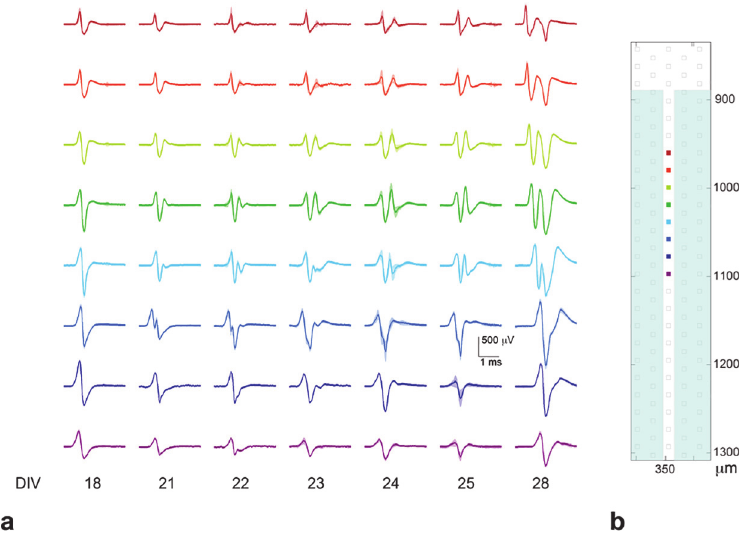
Fig 6. Spike shape evolution on eight electrodes in a channel over the course of 11 days. Signals on electrodes were consistent over short time periods (minutes) but changed dramatically over longer time periods (days). Colors were used to correlate (a) the spike shape with (b) the electrode position in the channel. The red (upper) electrode is closest to the channel entrance. Spike propagation was from the red electrode toward the purple electrode, which was about 200 μ m inside the channel. Spike shapes evolved significantly over several days. The simple bi-/tri-phasic axonal signal became a more complicated ‘ w ’ shape, probably as a result of axonal growth. The mean trace is shown, and the standard deviation of the spikes that were averaged together is outlined in a lighter